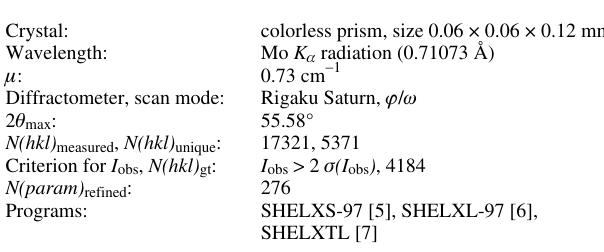
Table 1. Data collection and handling.